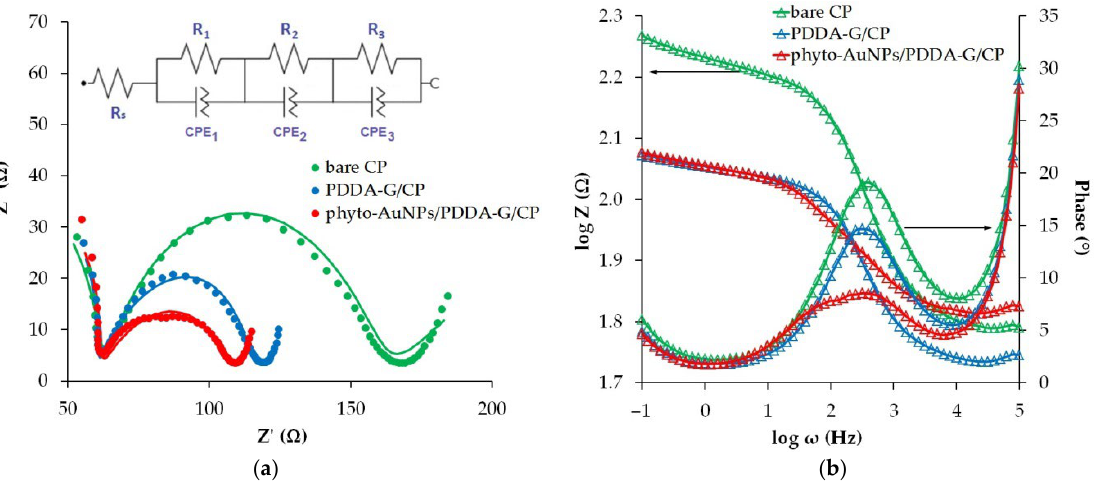
Figure 5. Experimental (points) and fitted (lines) Nyquist plots for bare CP, PDDA-G/CP, and phyto-AuNPs/PDDA-G/CP electrodes in 0.1 M KCl containing 5 mM [Fe(CN) 6 ] 3 − /4 − . Insert: scheme of equivalent cell ( a ). The Bode and the phase angle plots ( b ) .